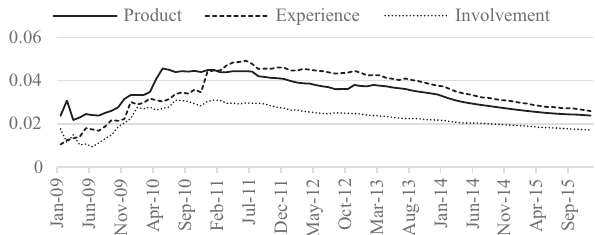
Figure 1. Cumulative feedback rate by